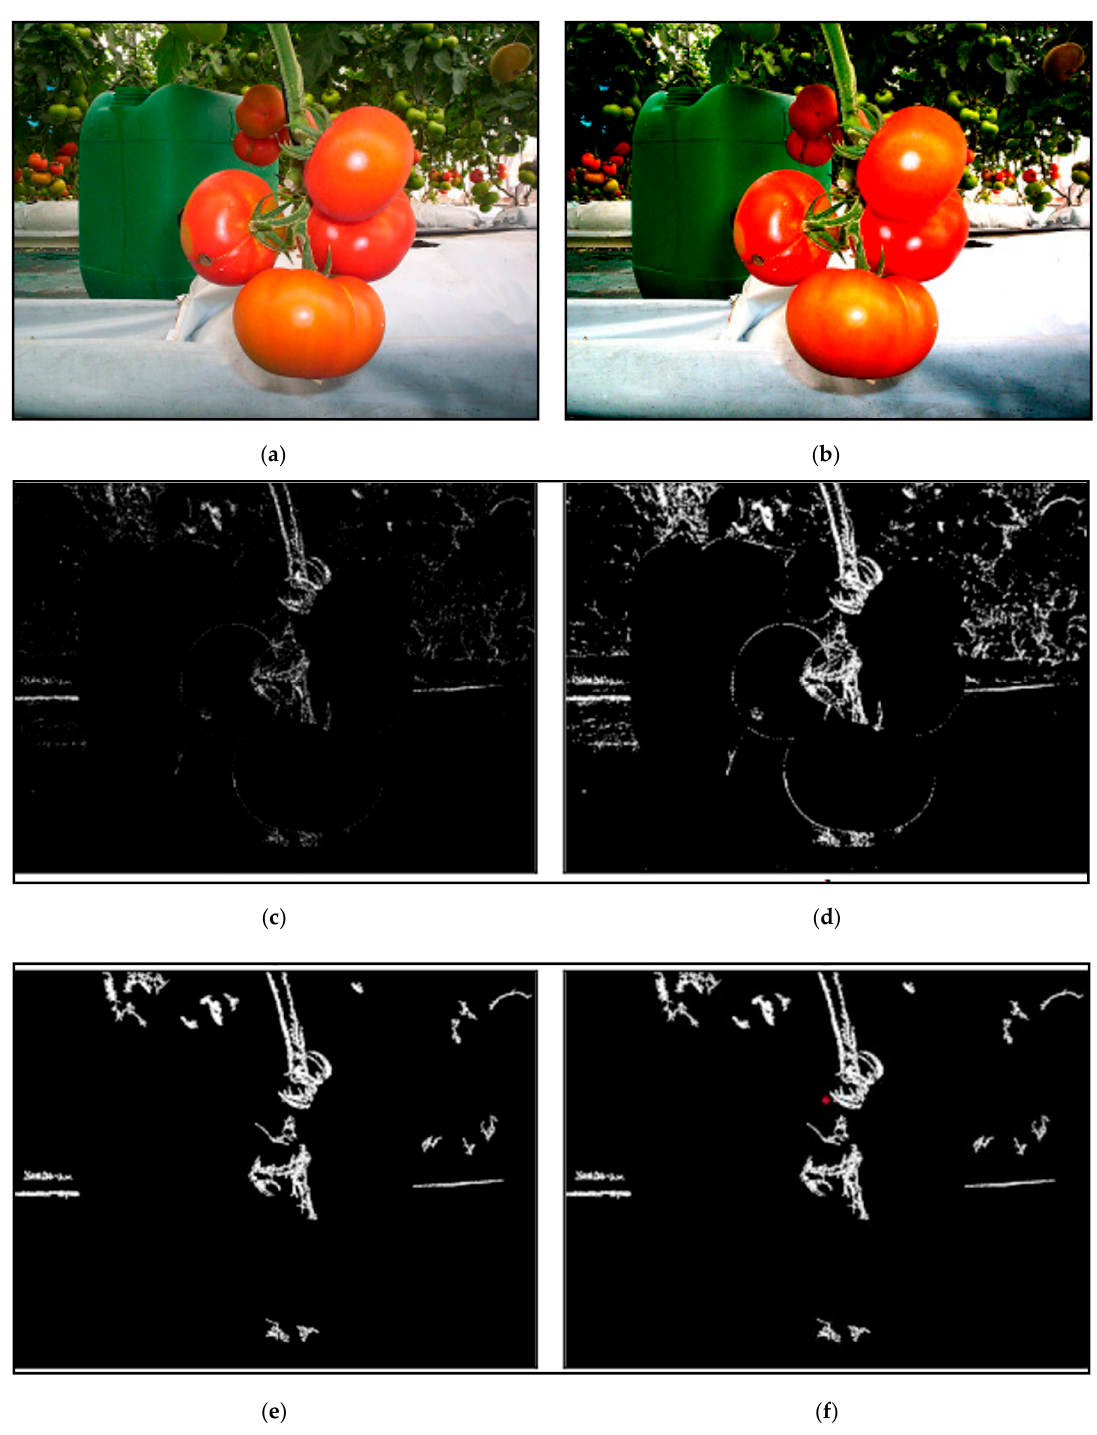
Figure 16. ( a ) Original image; ( b ) contrast enhancement; ( c ) color-based segmentation; ( d ) dilation; ( e )